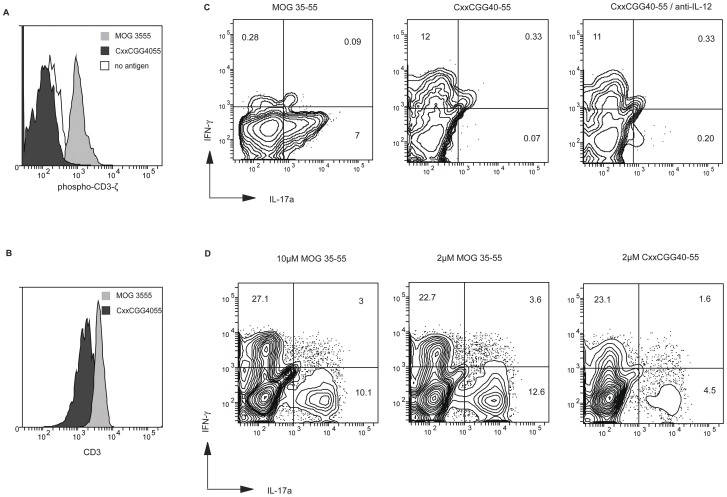
CxxC-containing epitopes prevent and suppress the generation of specific Th17 cells.(A) CD4+CD62L+ T cells obtained from 2D2 transgenic mice were polarized under Th17 conditions with T cell-depleted splenocytes from naive C57BL/6 mice either unloaded (open histogram), loaded with 2 µM MOG35–55 (light grey histogram) or MOG CxxCGG40–55 (dark grey histogram). After 20 minutes, cells were permeated and stained for intracellular phosphorylated CD3-ζ chain. Data are representative of two experiments. (B) The same cells as in (A) were stained for surface CD3 after 18 h of culture with MOG35–55 (light grey histogram) or MOG CxxCGG40–55 (dark grey histogram). (C) On day 6, cells polarized as in (a) and stimulated with MOG35–55 (left panel), modified CxxCGG40–55 (middle) or CxxCGG40–55 with anti-IL-12 antibody (right) were resuspended and restimulated with PMA/ionomycin for 6 h. After permeation, cells were stained for intracellular IL-17 and IFN-γ and analysed by flow cytometry. Numbers indicate percentages of cells in each quadrant. Data are representative of three experiments. (D) A CD4 T cell line was obtained from C57BL6 mice induced into EAE. After three in-vitro stimulations with peptide MOG35–55 in the presence of TGF-β and IL-23, cells were restimulated for three cycles with peptide MOG35–55 either at high concentration (10 µM) or normal concentration (2 µM), or with peptide CxxCGG40–55 (2 µM) in the presence of polarizing cytokines. On day 8 after the last stimulation, cells were tested for intracellular cytokines after stimulation with PMA/ionomycin as in (c).